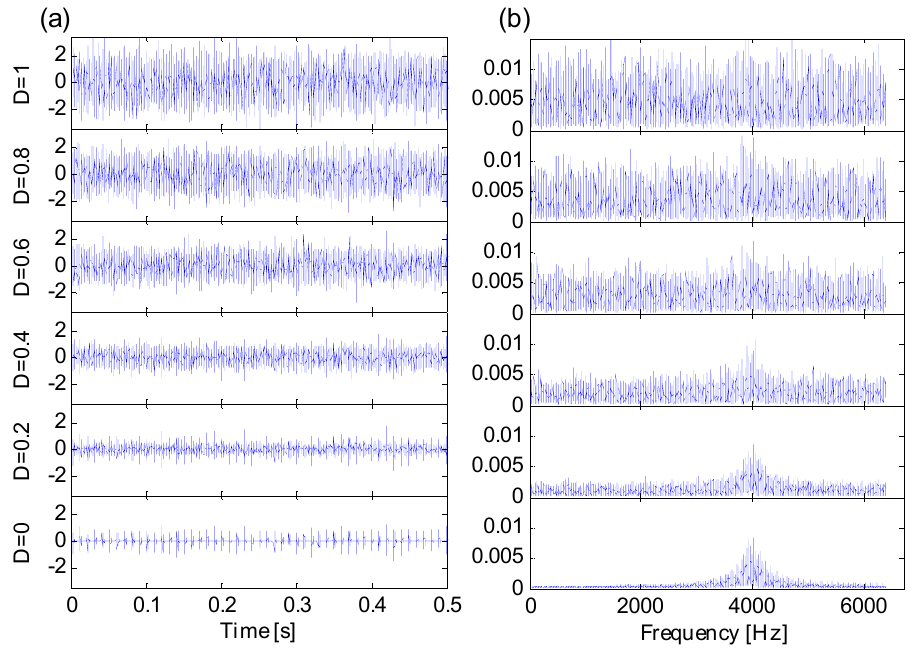
Figure 5. ( a ) Six simulation signals in time domain; ( b ) six simulation signals in frequency domain.